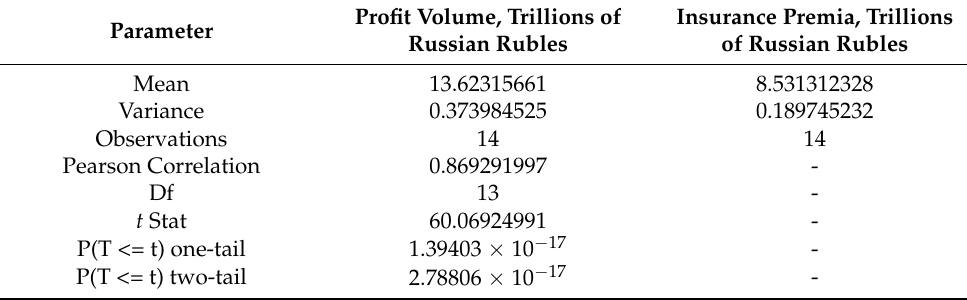
Table 3. t -test analysis of profit volume and insurances premiums size. Profit Volume, Trillions of Parameter Russian